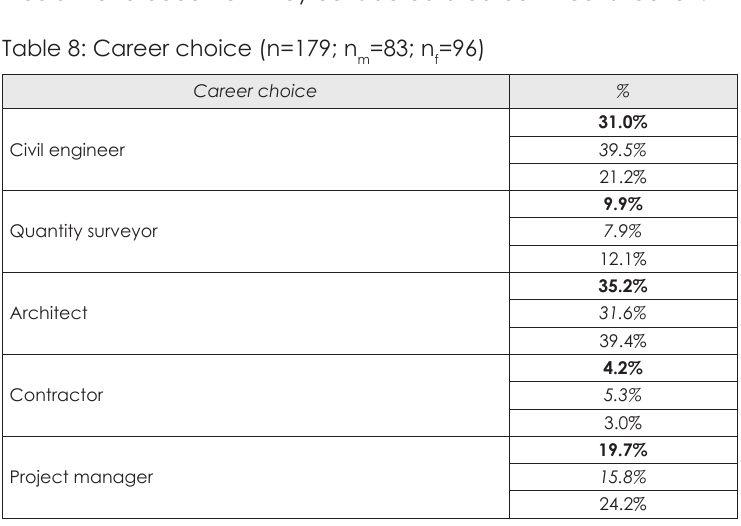
Table 8: Career choice (n=179; n